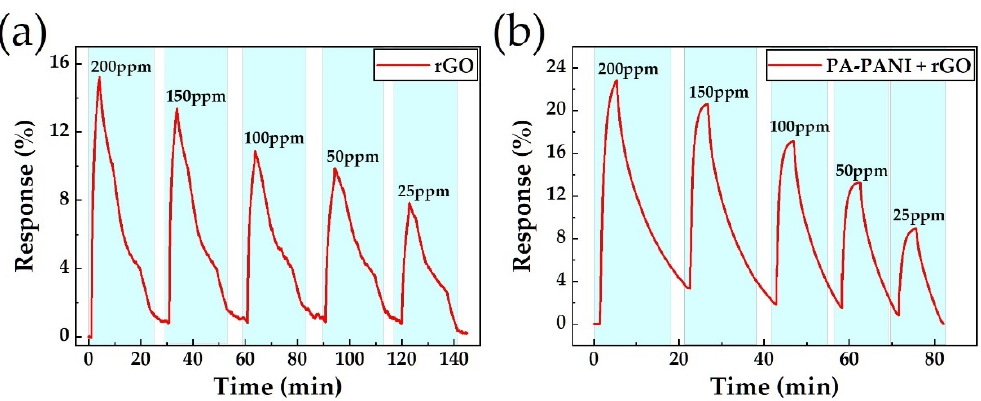
Figure 5. The relative NH 3 gas-sensing test results. ( a ) Test results of pure rGO membrane-based sensors. ( b ) PA-PANI/rGO composite membrane-based sensors.